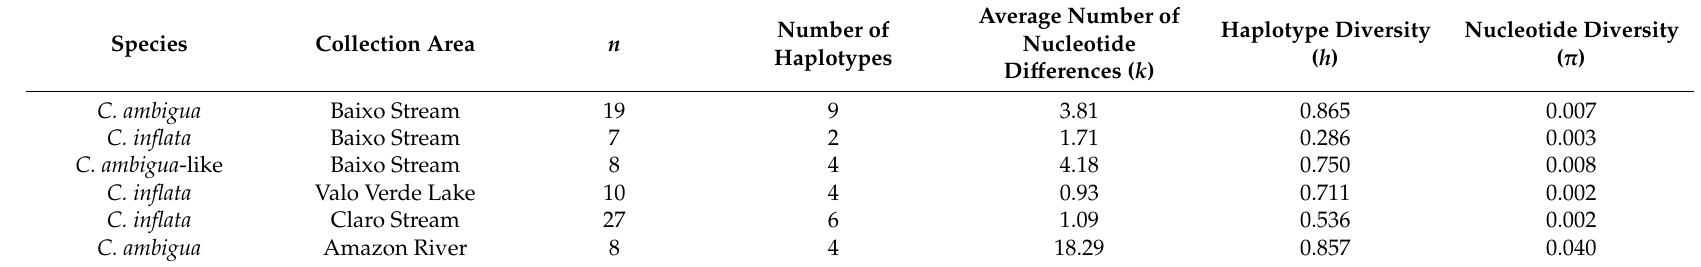
Table 5. Variation at the mitochondrial COI region for Castalia species among three sites in the upper Paraguay River basin and one site in the upper Amazon basin of